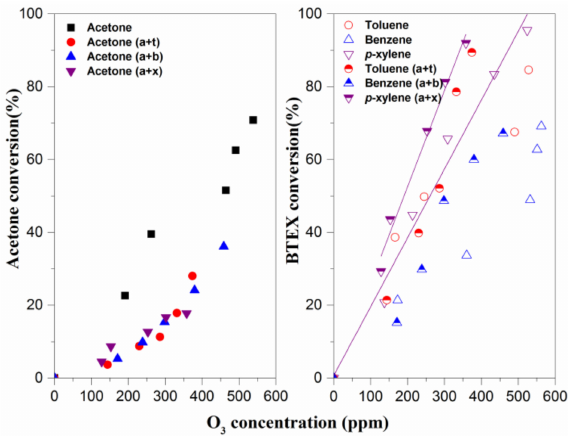
Figure 6. Effects of the O 3 concentrations on acetone ( left ) and BTEX ( right ) conversions. Reaction conditions: